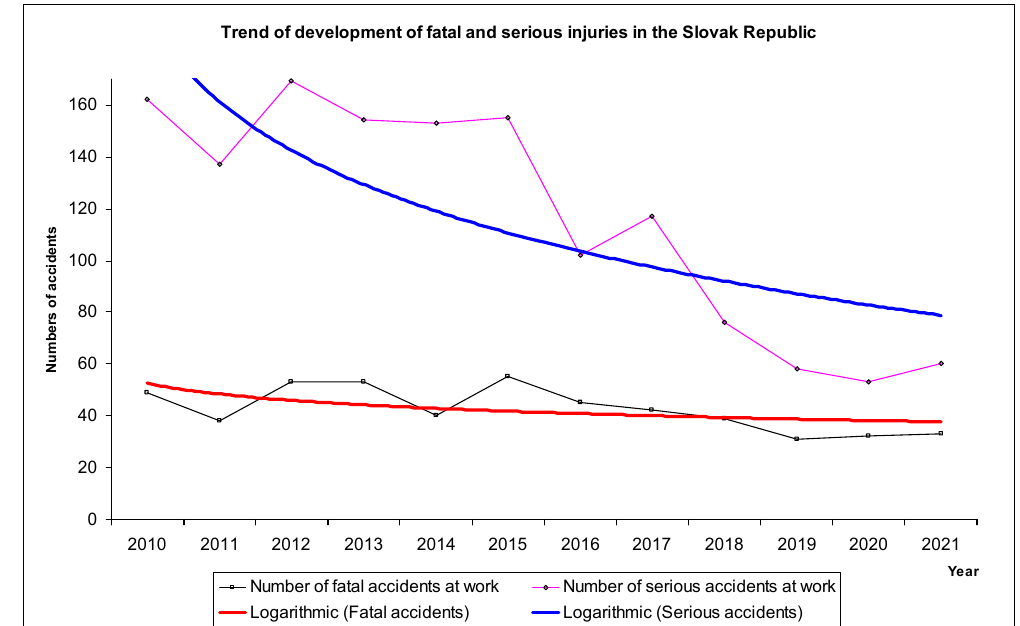
Figure 4. Trend of development of fatal and serious injuries in the Slovak Republic. As the standard STN EN ISO 45001:2019 came into force in Slovakia in March 2019, the trend in the number of fatal accidents and serious accidents is declining.